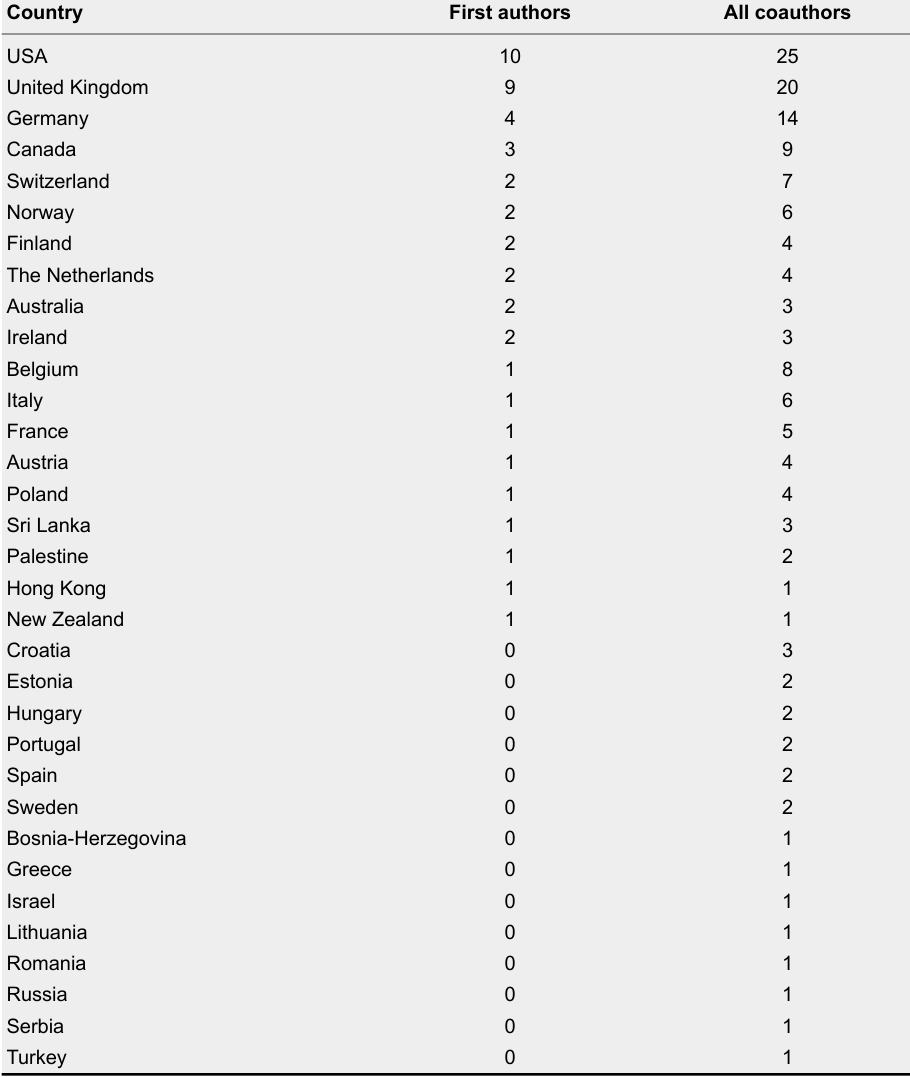
All coauthorsFirst